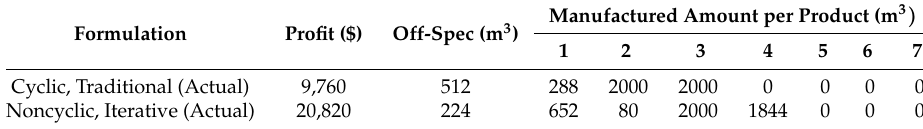
Table 28. Economic results: Scenario 5.